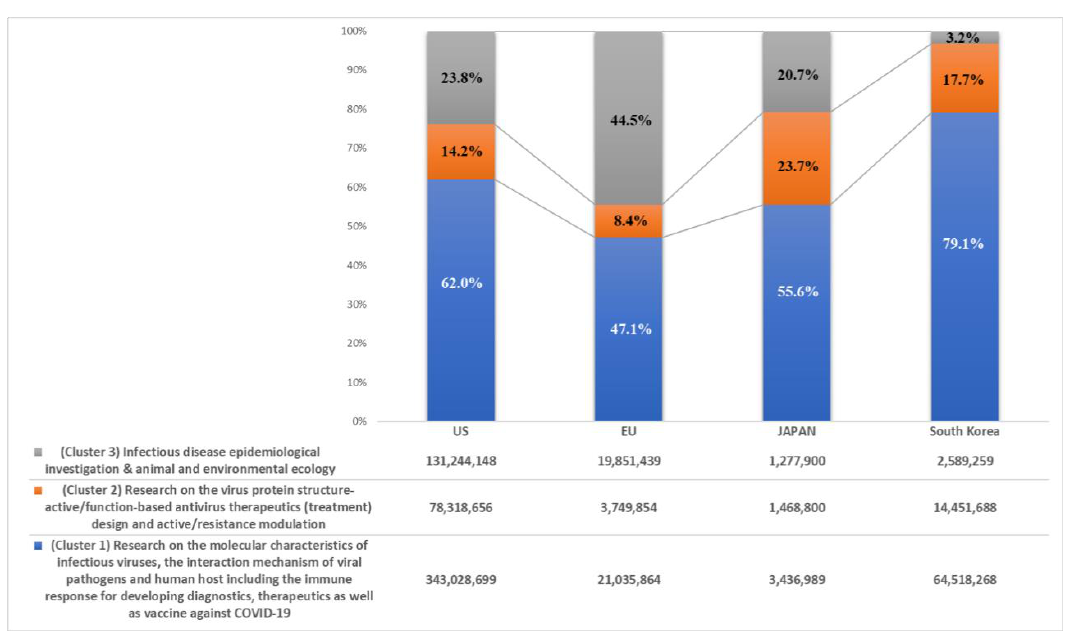
Figure 3. Comparative ratio analysis for three coronavirus-related R&D areas among the US, the EU, Japan, and Korea.